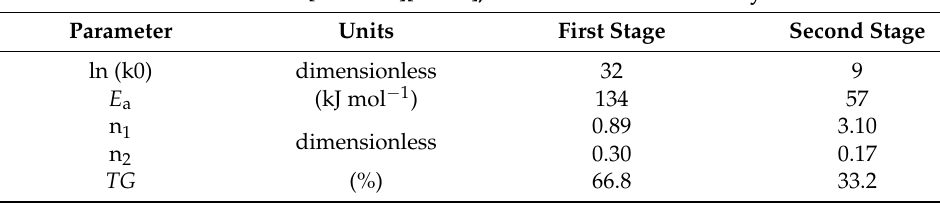
Table 1. Thermokinetics parameters evaluation for [BZMIM][TF2N] of the heating rates of 0.5, 1.0, 2.0, 4.0, and 8.0 ◦ C min − 1 .